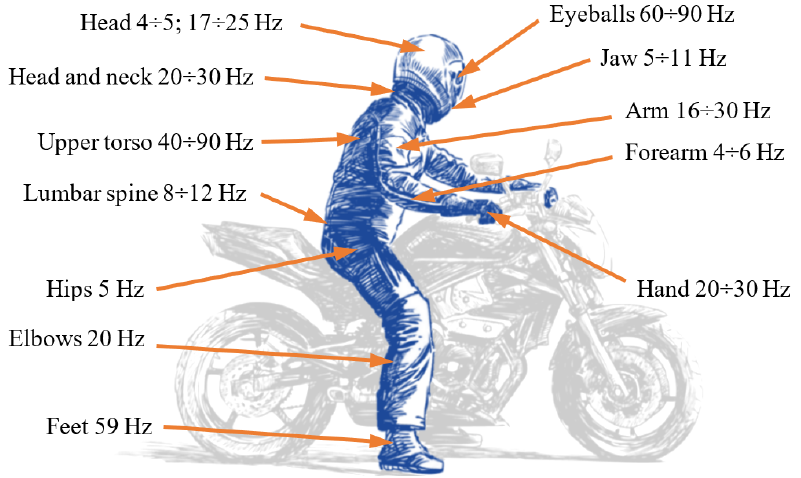
Figure 1. Natural frequencies of selected organs and parts of the human body.